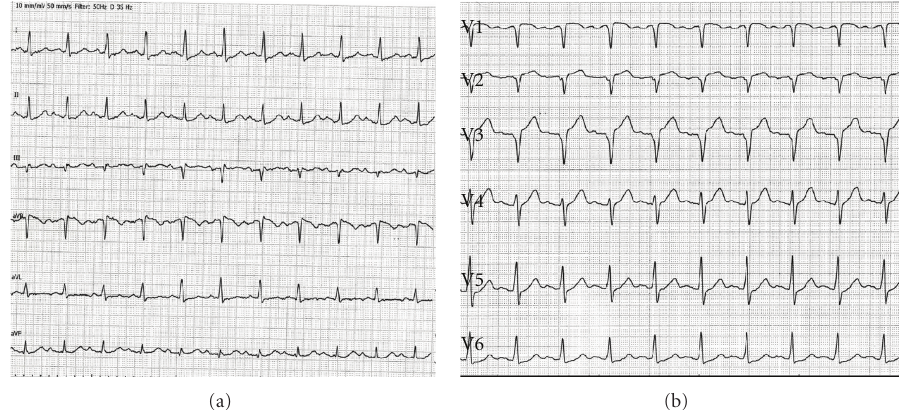
Figure 1: Standard 12-lead ECG shows sinus rhythm at 120 bpm, poor R wave progression in V1–V3 leads, an increased S wave in V1–V3 associated with ST segment elevation in V1–V3.